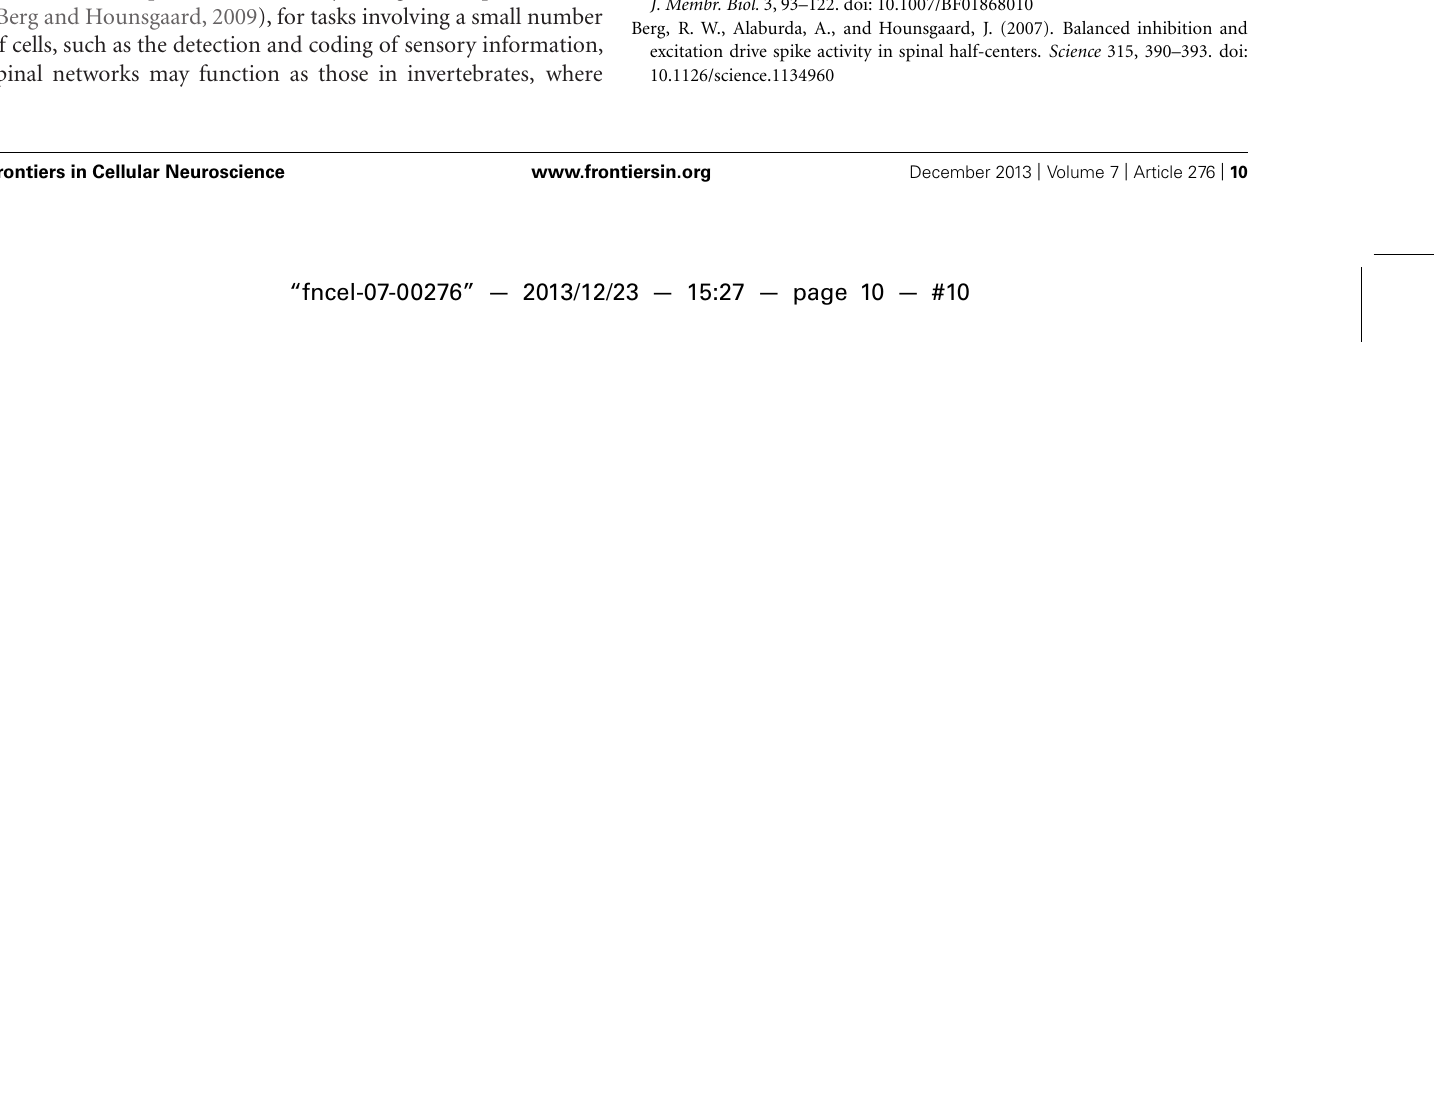
FIGURE 8 |Windup to repeated sensory stimulation is eliminated by blockade of L-type Ca 2 + channel. (A) Response to a depolarizing current pulse in a plateau potential generating cell. (B) Instantaneous firing frequency in response to 50 pA current pulse before (control) and after